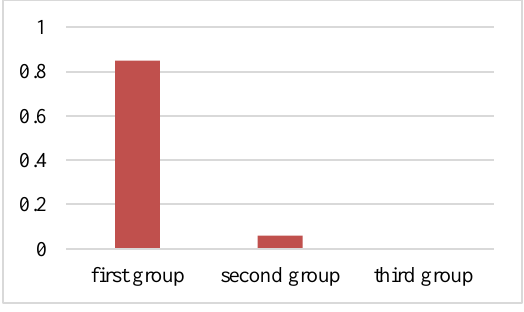
Figure 4. The fear mode in autistic children